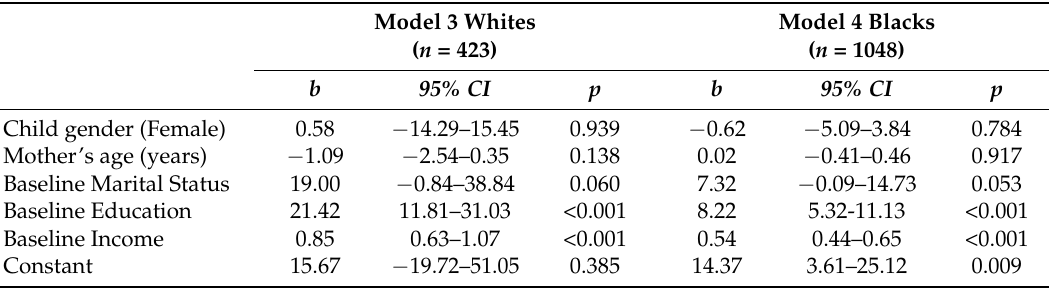
Table 4. Summary of two linear regressions by